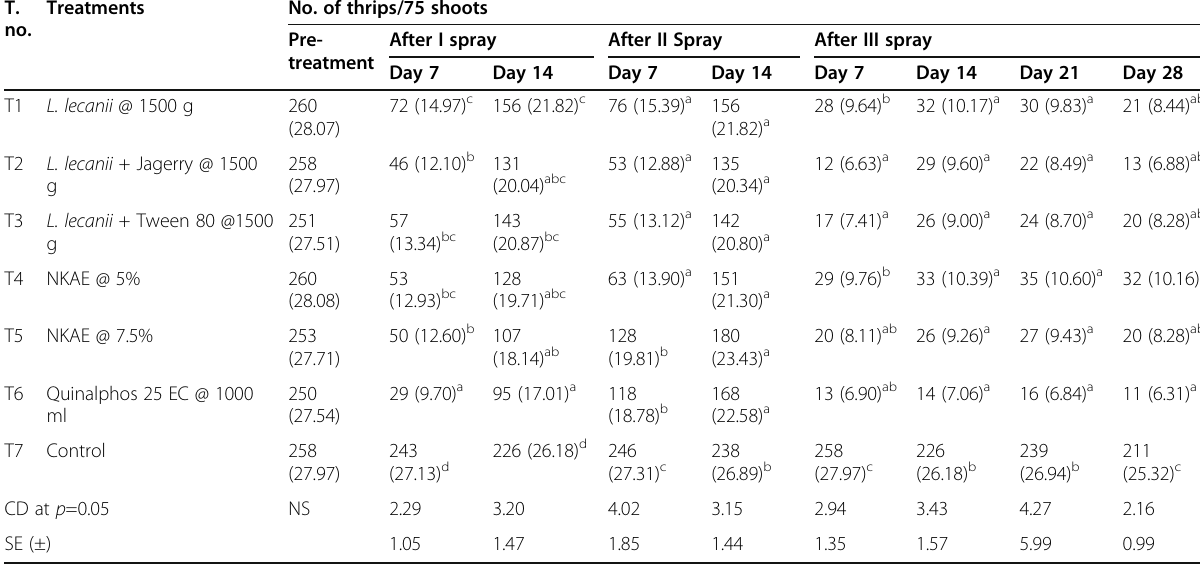
Table 4 Large scale field bio-efficacy trial (RBD) of Lecanicillium lecanii against thrips (season I) T. no.